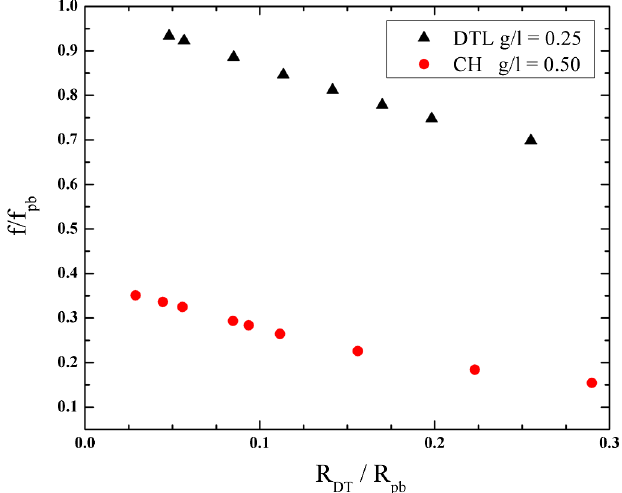
FIG. 3. The effect on the insertion of the accelerating structure on the resonance frequency of the corresponding pillbox cavity for an Alvarez DTL and for a CH-DTL.